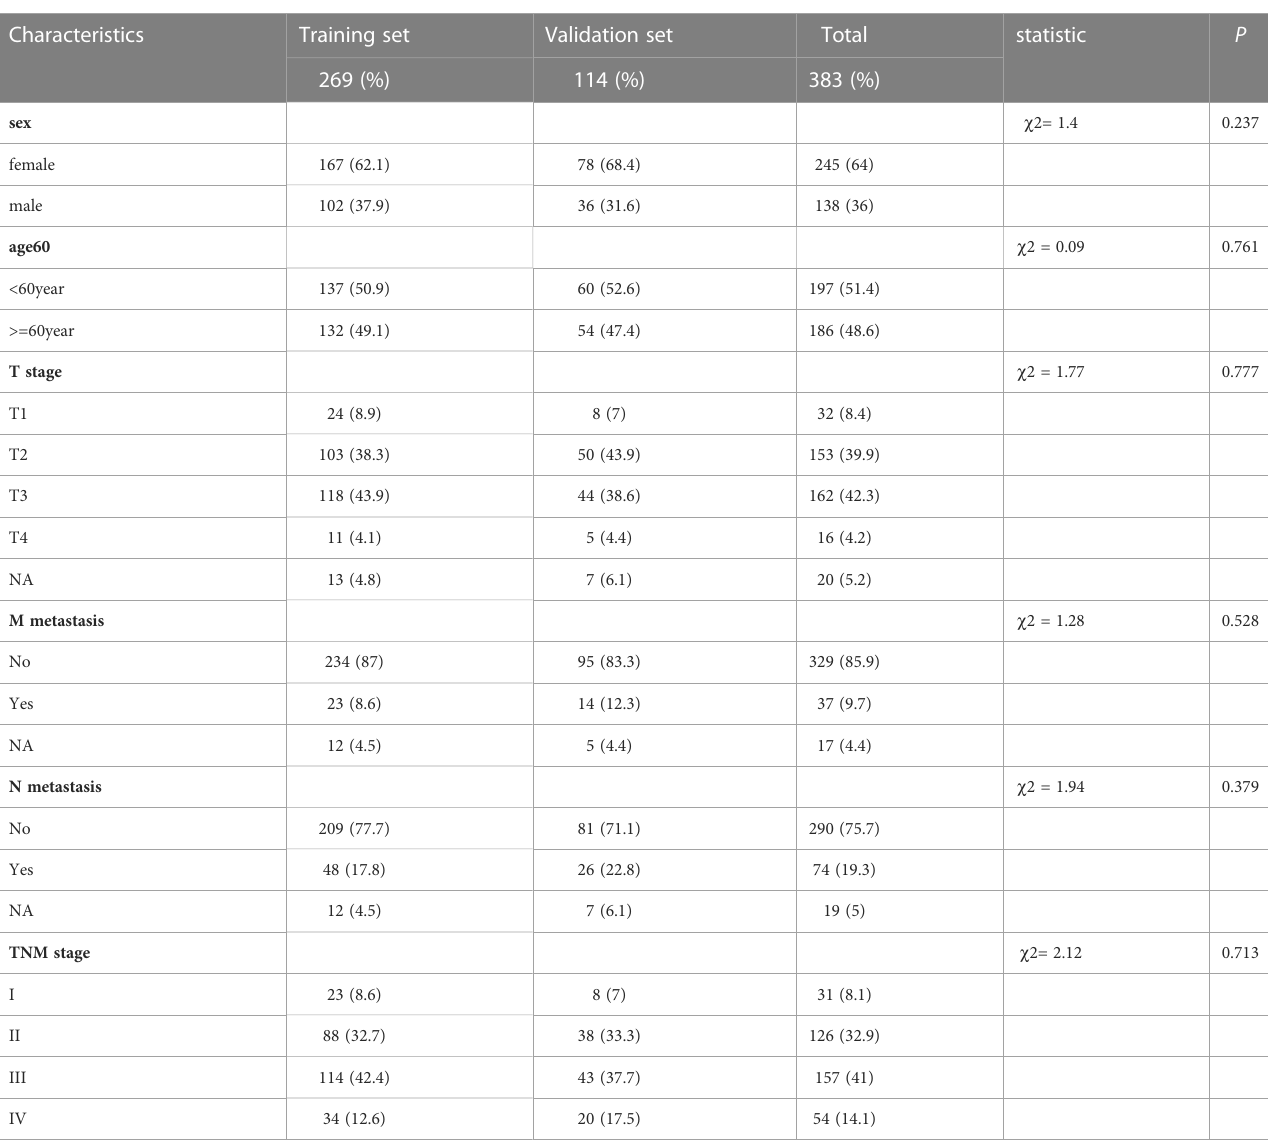
TABLE 1 Characteristics of incidental gallbladder cancer patients in the Training and Validation set. Characteristics Training